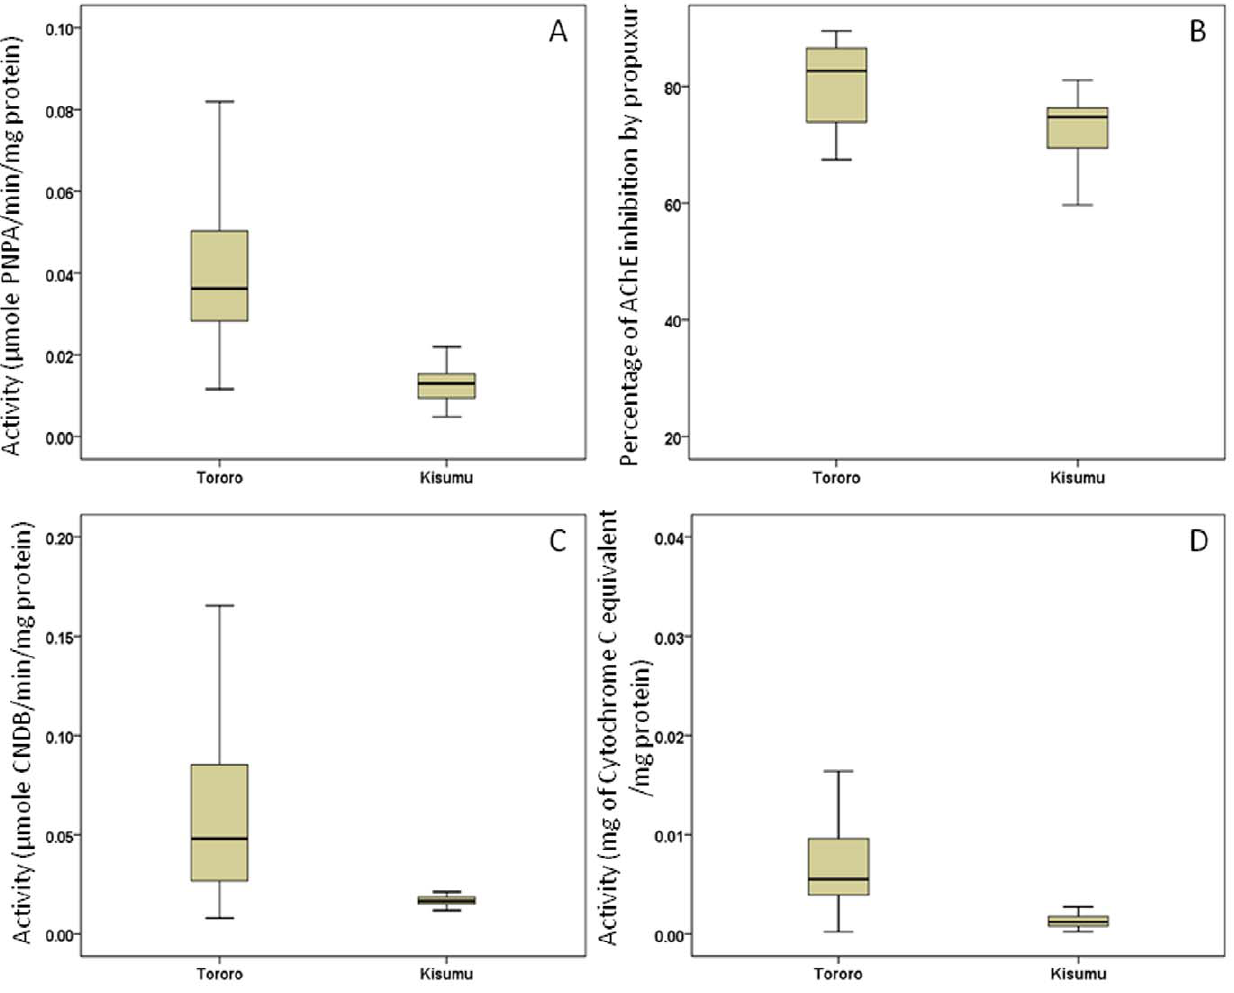
Figure 1. Box plots of results from biochemical assays. The median activity of the An. funestus population of Tororo compared with the An. gambiae Kisumu reference strain is shown by a horizontal bar; the box denotes the upper and lower quartiles. The vertical lines show the full range of the data set; (A) Range of esterase activity with the substrate p -nitrophenyl acetate; (B) Acetylcholinesterase inhibition ranges. (C); Range of GST activity. (D) Estimated levels of cytochrome P450s (representing monooxygenase activity).